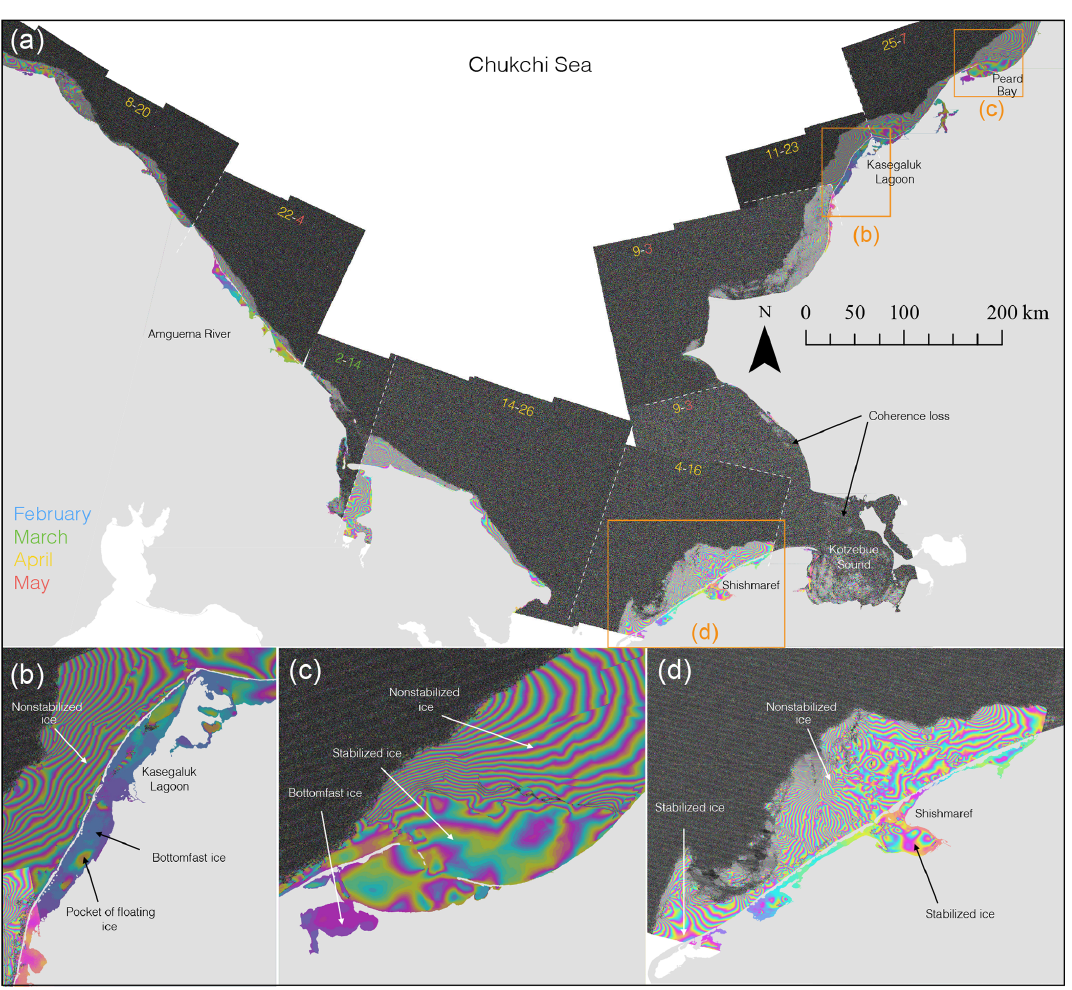
Figure 5. (a) Sentinel-1 interferograms derived from image pairs acquired over the Chukchi Sea between March and May 2017. Numbers on images represent date ranges. The colors blue, green, yellow, and red signify the months of February–May. (b, c, d) Three enlarged areas identified in (a) are further discussed in the